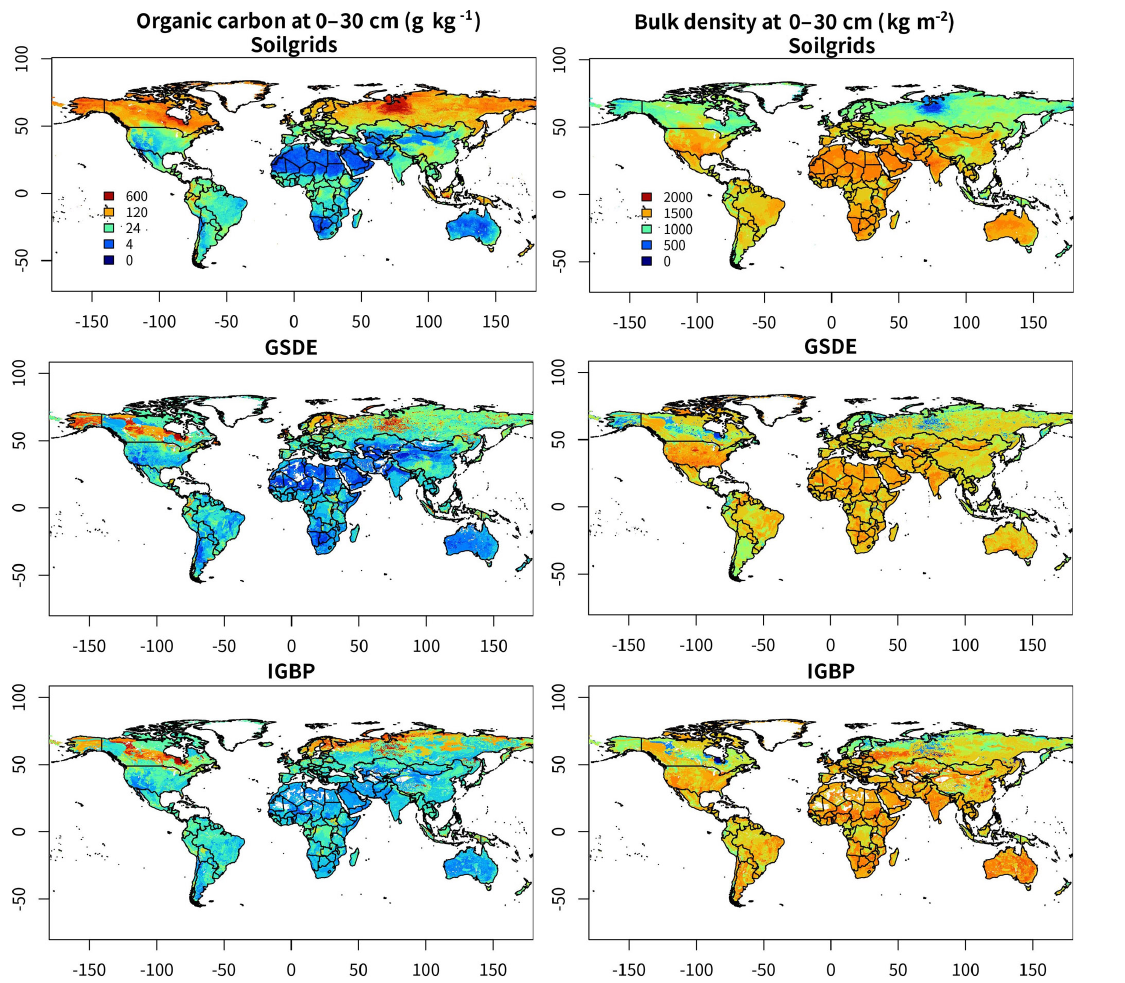
Figure 2. Soil organic carbon and bulk density at the surface 0–30cm layer from SoilGrids, GSDE, and